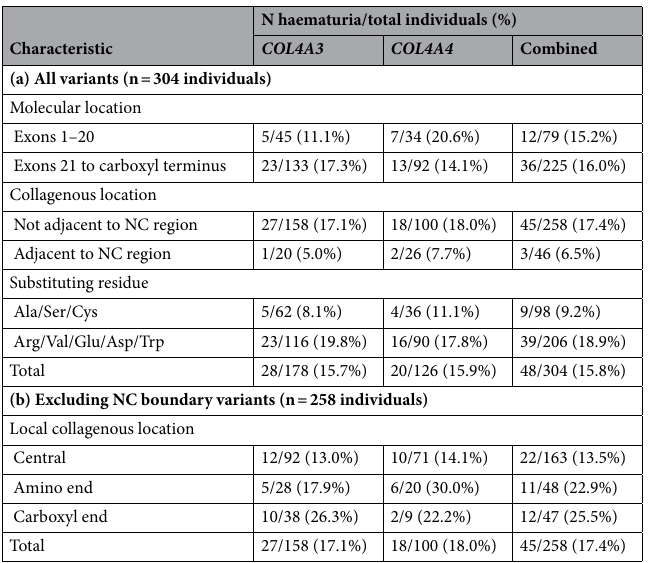
Table 3. Haematuria distribution and COL4A3 / COL4A4 Gly missense variant features of individuals reported in the 100kGP database. NC, non-collagenous.